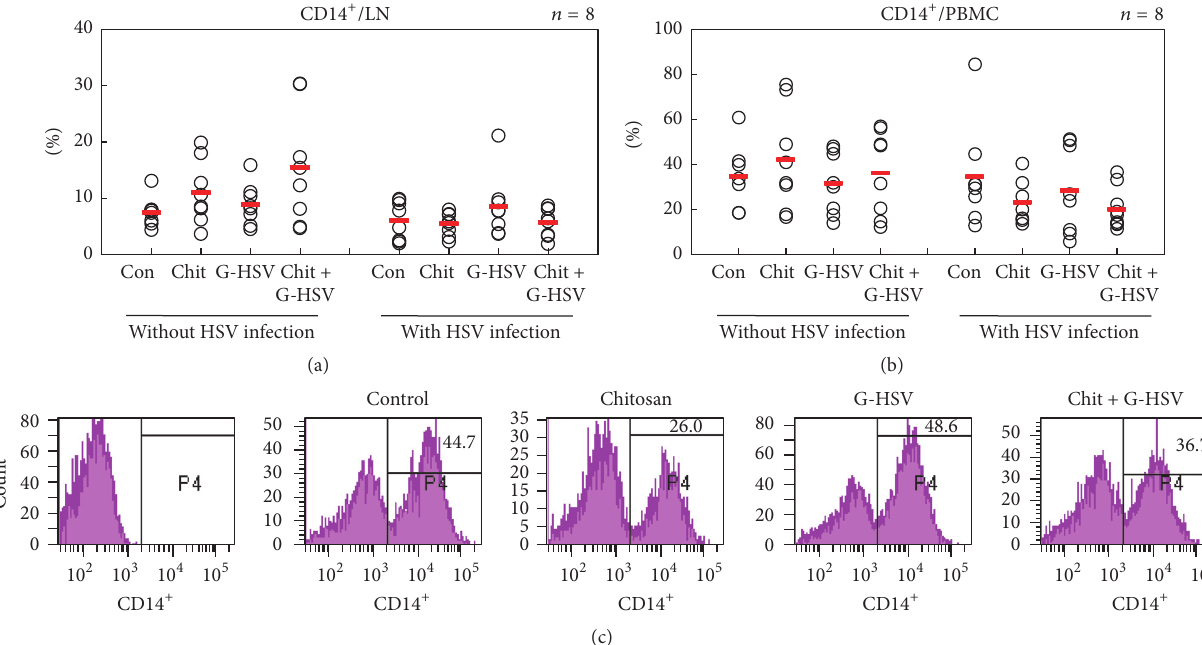
Figure 3: Chitosan has no influence on the frequencies of CD14 + monocytes. Chitosan did not significantly regulate the frequencies of CD14 +